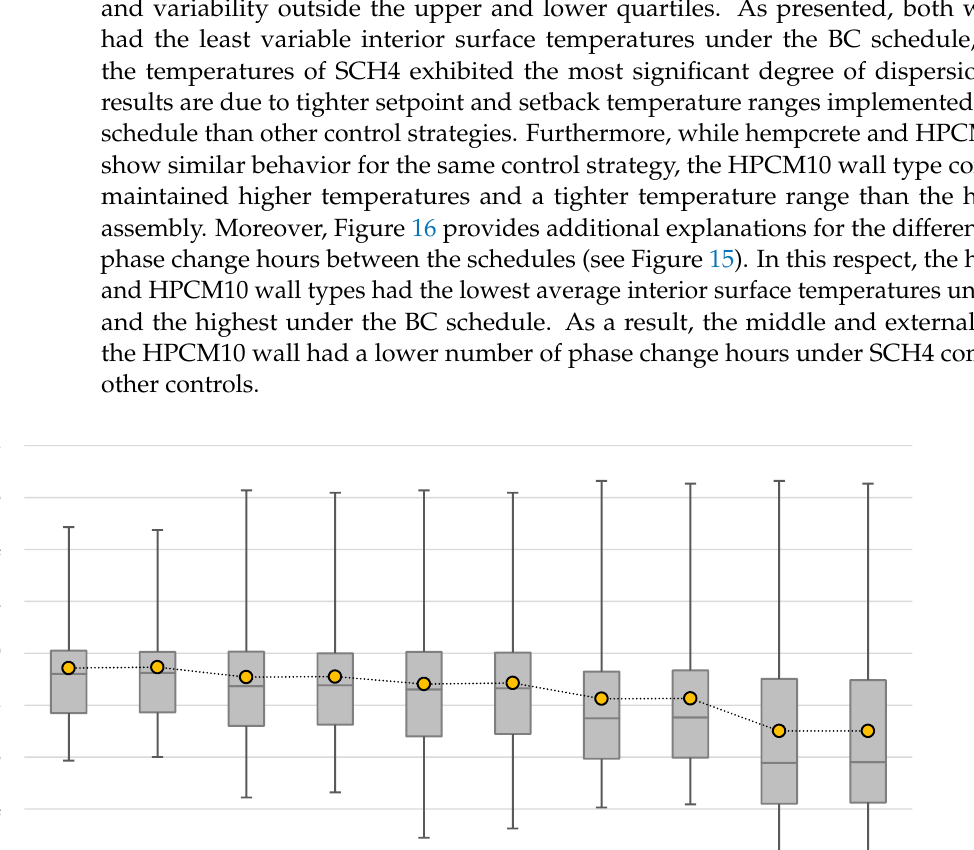
Figure 15. The number of phase change hours of the HPVM10 wall under different temperature control strategies.